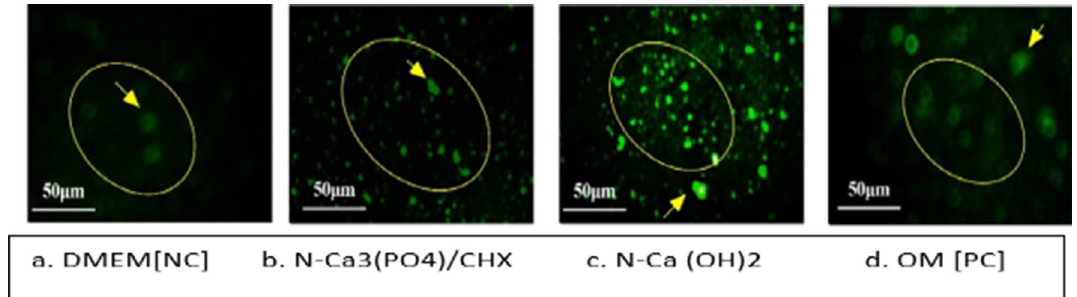
Fig. 6 Expression of DMP1 protein expression in differentiated odontoblasts by immunofluorescence a a discrete of cells with a homogeneous faint expression of DMP with immunofluorescence intensity ( ) was found in the negative control cells The expression was localized to the cell + membrane. b , c HDPSCs co-cultured with N-Ca3(PO4)/CHX, N-Ca(OH)2 revealed a merged big colony of odontoblasts with dense homogeneous membrane and nuclear DMP expression. d HDPSCs were co-cultured in an Osteogenic medium (OM), resulting in an increased number of odontoblast colonies with faint homogeneous DMP expression ( ) and an H-score of 110. The magnification is 10X. The odontoblast colonies are + + highlighted by the yellow circles, and the yellow arrow indicates DMP expression in the membranous and nuclear